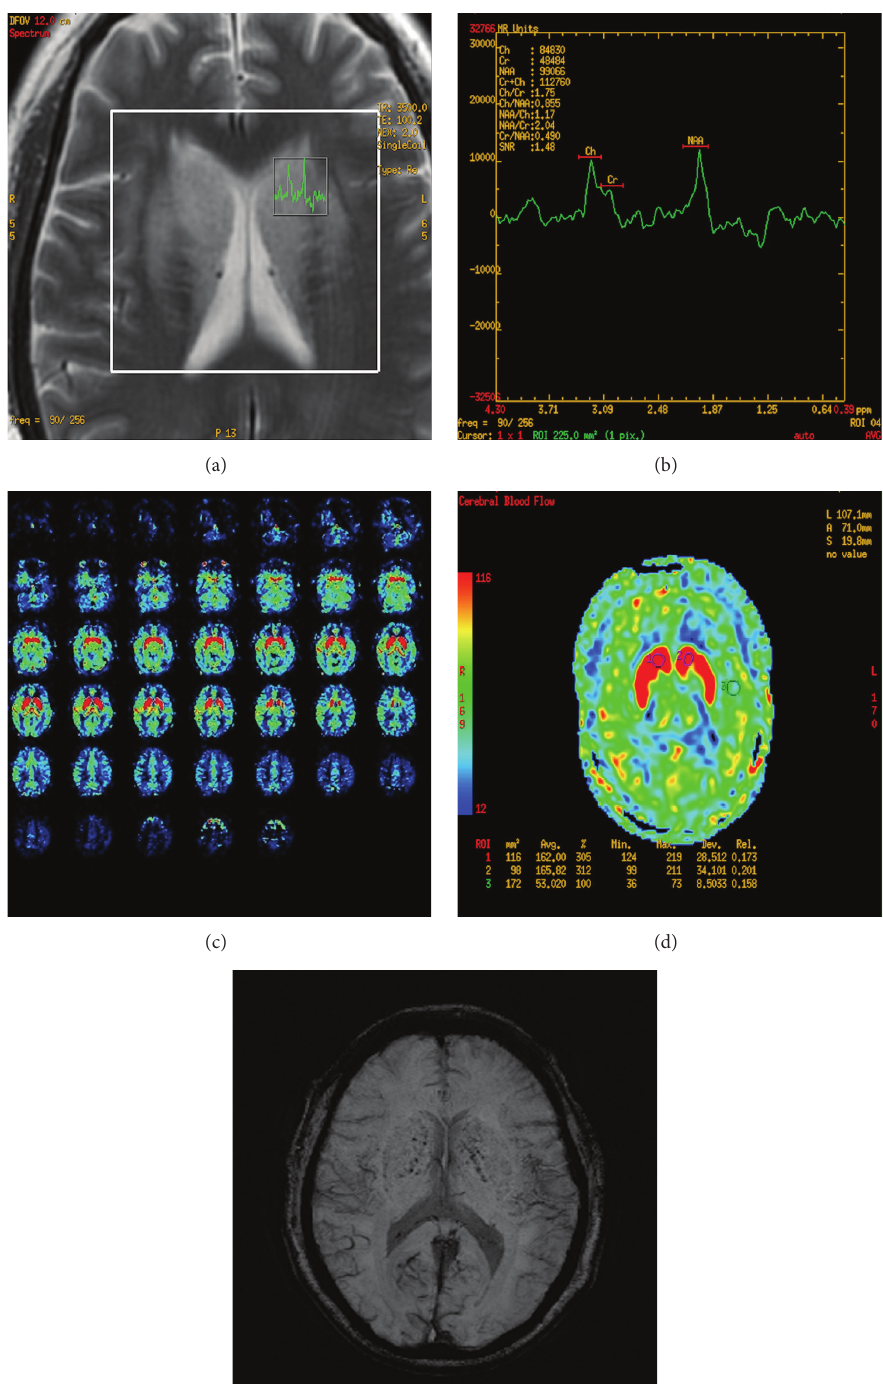
Figure 3: (a, b) MRS with region of interest pinpointed on the left basal ganglia lesion displayed a decrease of NAA/Cr value (2.04) and lactate doublet was detected. (c, d) 3D-ASL showed hyperperfusion in the lesion area and the rCBF was more than 160 mL/(100g ∗ min). (e) SWI findings indicated old microbleeds and hemosiderin